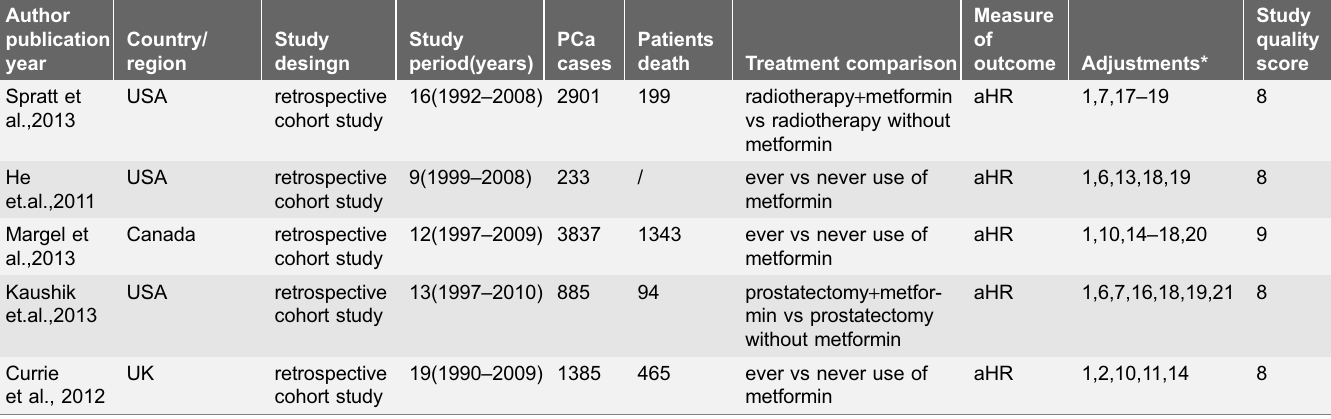
Table 3. Characteristics of the included studies for the all-cause mortality of the prostate cancer